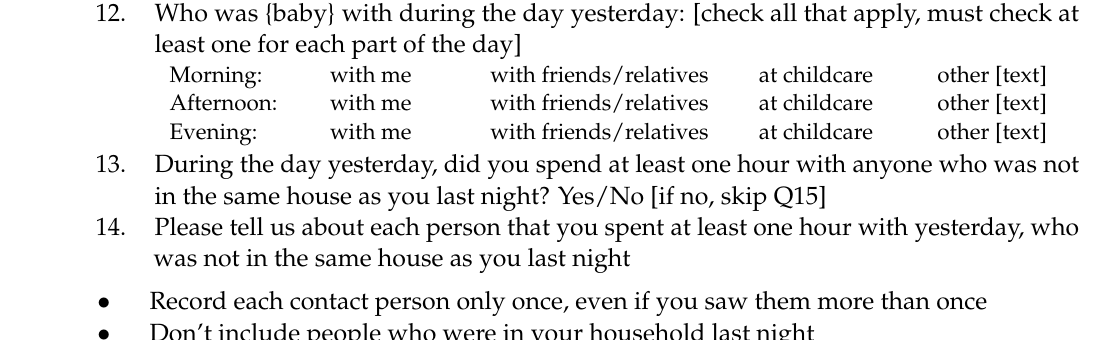
Table A1. A short example of the data collected on social contacts . Contact No.